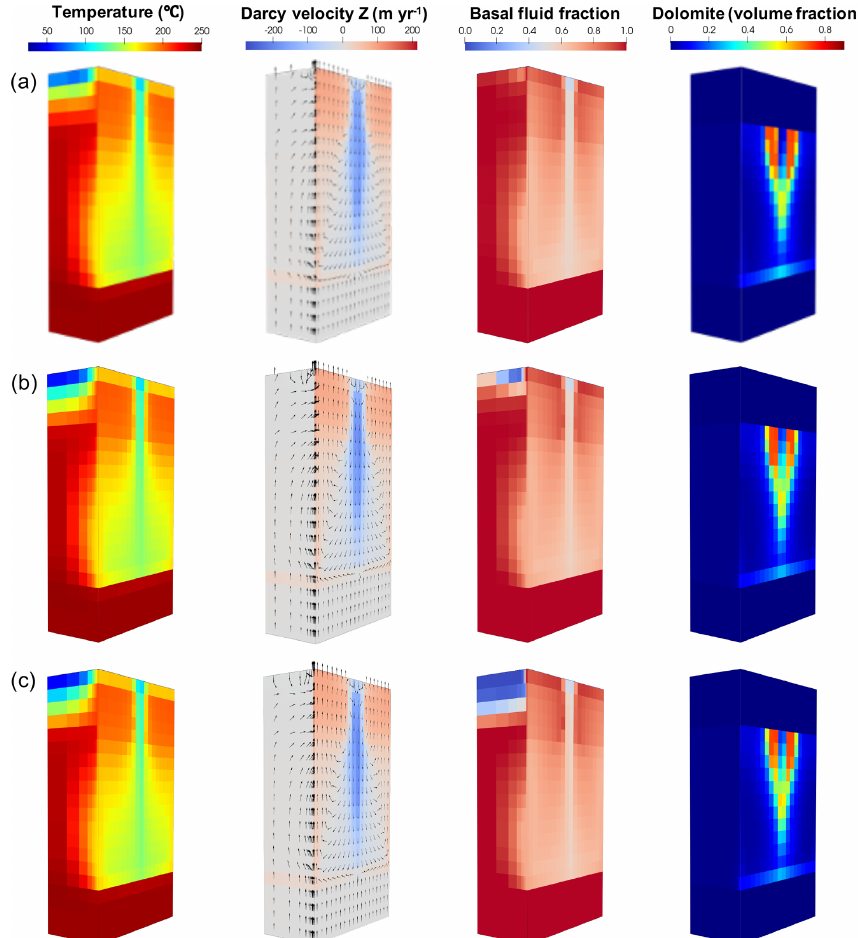
Figure 10. Simulation results at 15kyr from (a) the baseline 3D model, (b) the 50% lower permeability caprock model (5 × 10 − 16 m 2 ), and (c) the 90% lower permeability caprock model (10 − 16 m 2 ) showing no significant difference in heat transfer, fluid flow (black arrows), distribution of dolomitisation, or basal fluid fraction. The orientation of panels is identical to Figs. 4 and 8. Note that the Darcy velocities are positive when the flow is upward and negative when the flow is